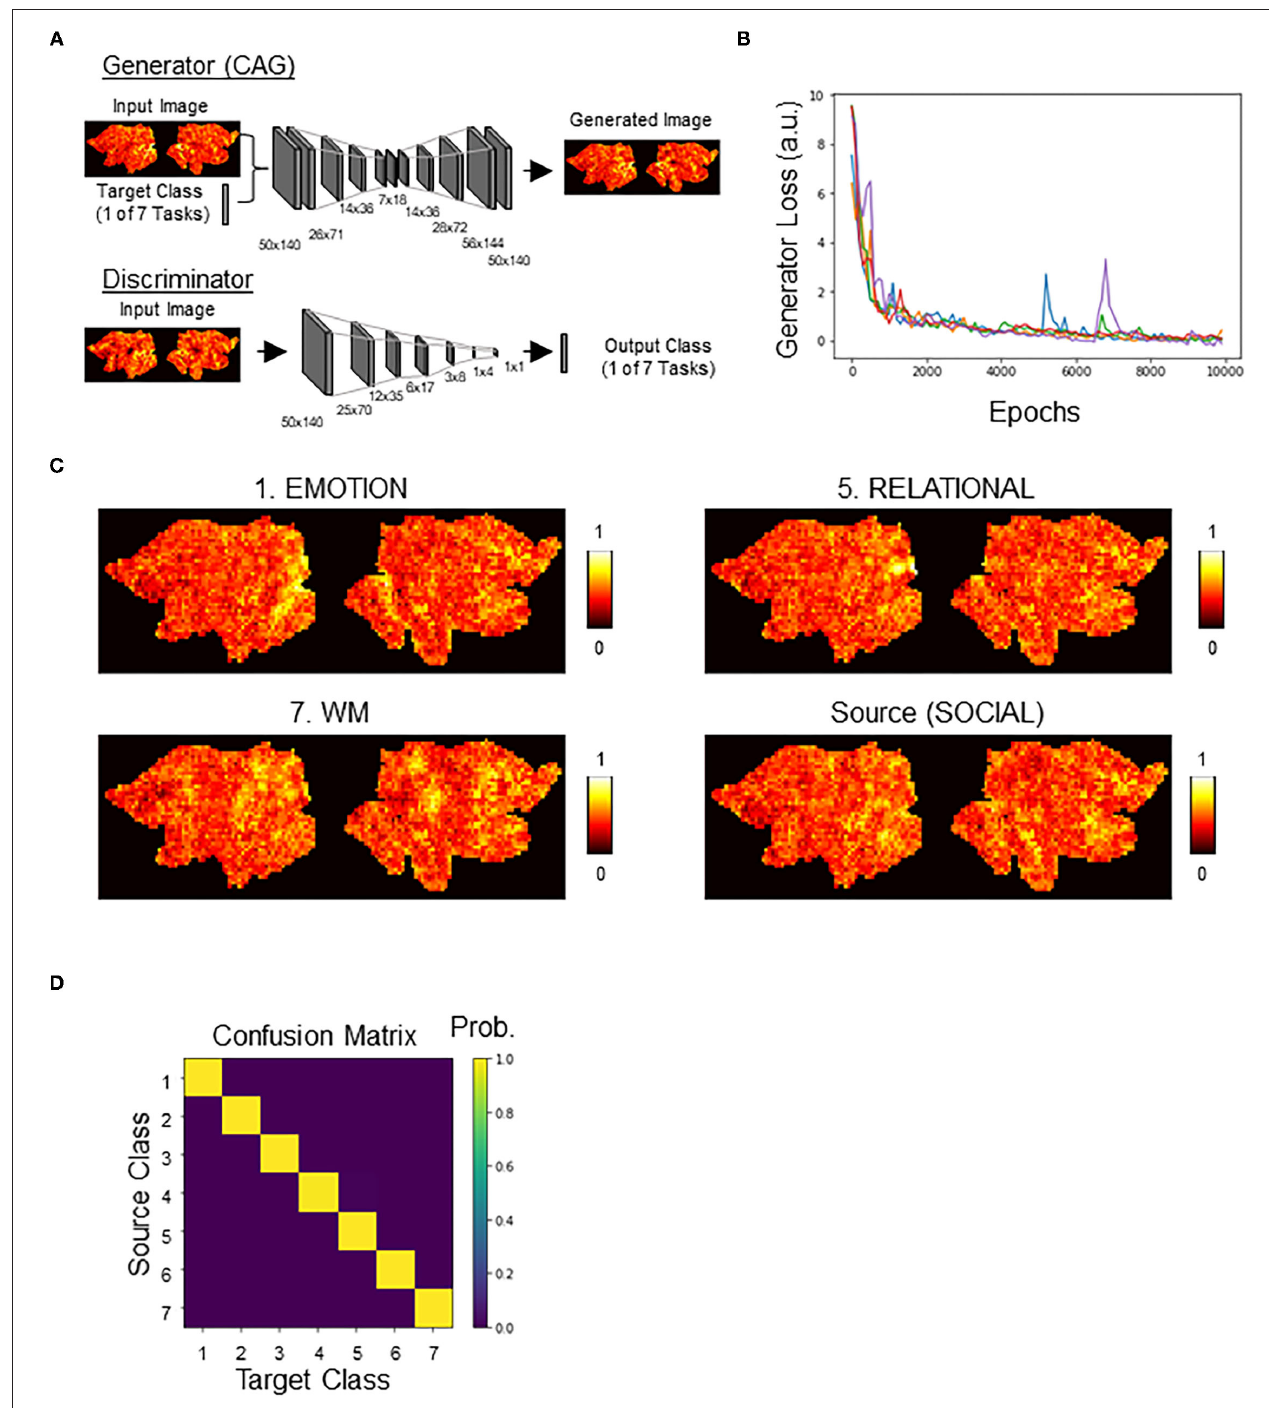
FIGURE 3 | Counterfactual activation generator (CAG). (A) Generator and discriminator architectures, see Methods for details. Networks were modified from StarGAN. Generator, once trained, served as CAG. Generator takes a combination of an image of brain activation and a one-hot label indicating the target class as an input. Generator outputs a counterfactual brain activation that is a minimal transform of the input brain activation toward the target class. Discriminator takes an activation map output by generator and outputs a one-hot label. Discriminator was cotrained with generator, as in StarGAN. (B) Time courses of the generator loss. Different colors indicate different replicates ( n = 5). (C) Representative counterfactual activations generated by CAG. All counterfactual activations were generated from the source activation. See Supplementary Figure 3 for transformation to all categories. (D) Confusion matrix showing the classifier’s decision profile on counterfactual